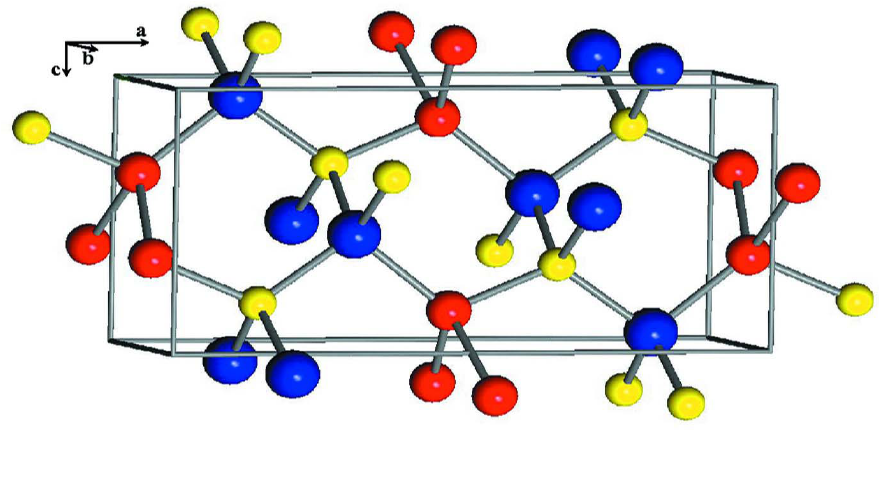
Figure 2 The crystal structure of lautite showing the linking of Cu[AsS yellow circles indicate Cu, As and S atoms, respectively. The unit-cell is outlined. copper arsenic sulfide Crystal data AsCuS M r =